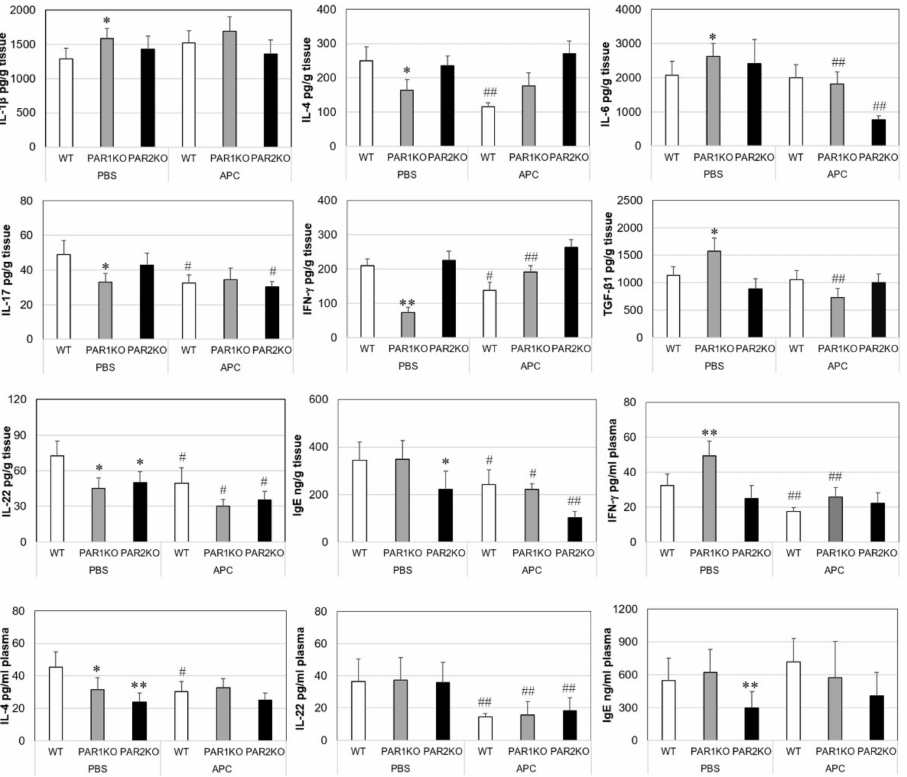
Figure 3. Cytokines and IgE in ear tissues or plasma from mice with CHS. Mice were euthanized at day 14 after DNFB challenge. Ear tissues were homogenized, cytokines and IgE in clear supernatants of tissue homogenates and plasma were measured by enzyme-linked immunosorbent assay. Data shown on graph are means ± SD ( n = 8 for all groups). * p < 0.05, ** p < 0.01 vs. WT. # p < 0.05, ## p < 0.01 vs. its own control